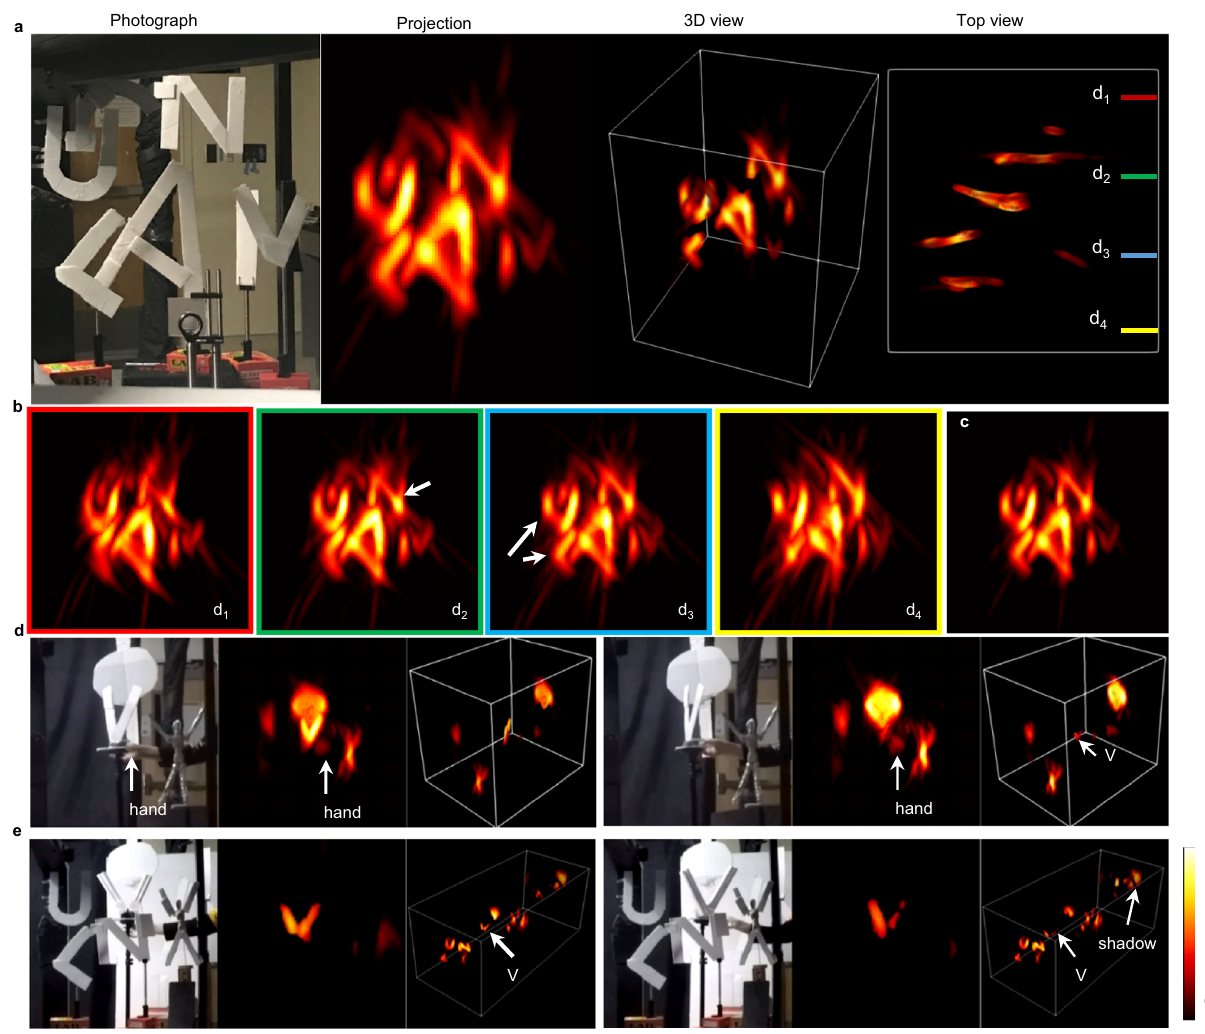
Fig. 3 Snapshot fl ash LiDAR imaging over an extended depth range. a Flash LiDAR imaging of a letter scene. From left to right are the reference photographs, a projected two-dimensional LiDAR images along the depth direction, and the 3D (three-dimensional) point-cloud representation of the scene. b fl ash LiDAR of the same 3D scene without extending the imaging depth of fi eld, obtained by refocusing the camera onto a single focal plane. Note the defocus blur in the near and far objects. c Computational all-in-focus image. d and e Two representative frames for the dynamic imaging of a manually rotated letter V in a simple and cluttered scene,